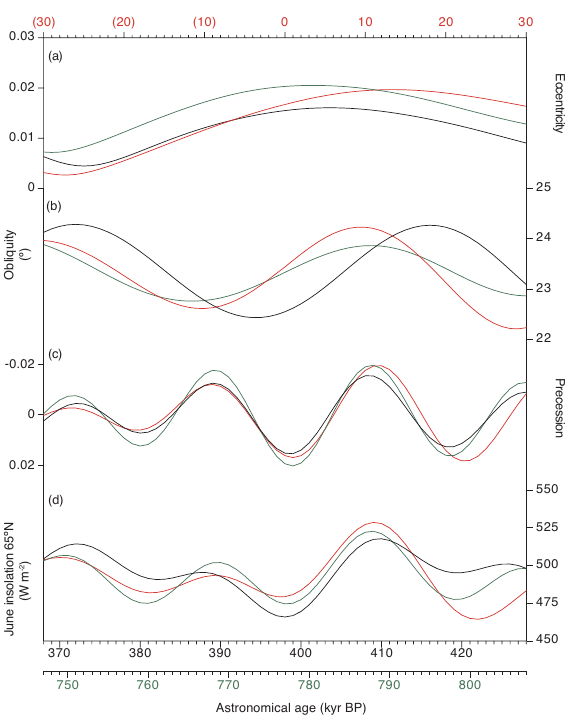
Fig. 6. Comparison of astronomical parameters of the past and fu- ture 30kyr (red), a 60-kyr interval encompassing MIS 11 (black) and a 60-kyr interval encompassing MIS 19 (green). (a) eccentric- ity (Berger and Loutre, 1991); (b) obliquity (Berger and Loutre, 1991); (c) precession parameter, plotted on an inverse vertical axis (Berger and Loutre, 1991); (d) 21 June insolation 65 ◦ N (Berger and Loutre, 1991). Ages in parentheses denote thousand years after present (kyr AP).